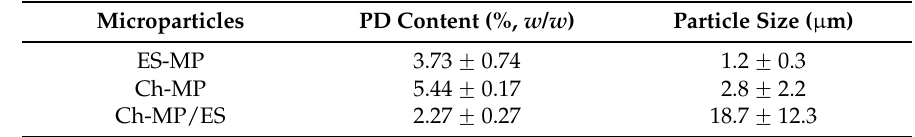
Table 1. Particle characteristics of ES-MP, Ch-MP and Ch-MP/ES.